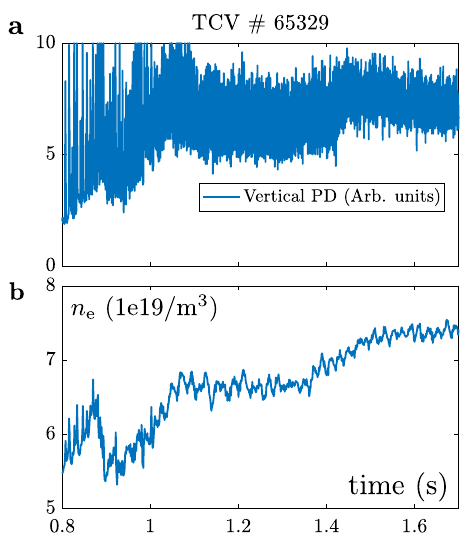
Fig. 9 Edge Localized Mode evolution. a Time trace of the vertical photodiode (PD, equipped with with D α - fi lter) for TCV discharge #65329. The varying ELM size over the course of the discharge is re fl ected in the amplitude of the photodiode signal. b Evolution of the line averaged core density n e as measured by